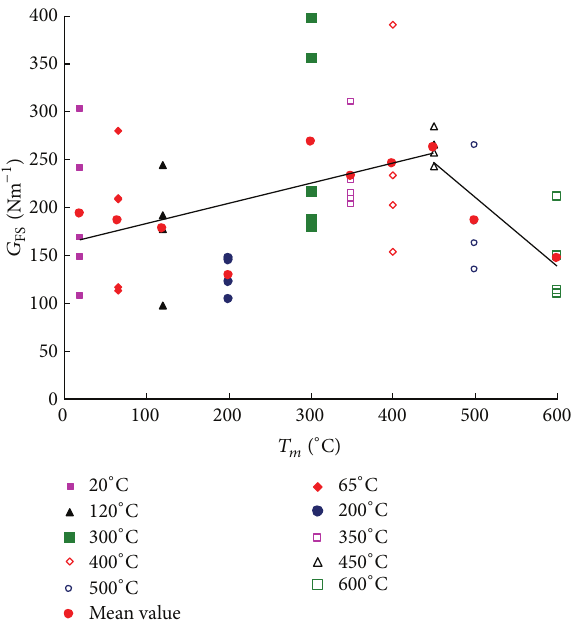
Figure 12: Stable fracture energy with 𝑇 𝑚 .